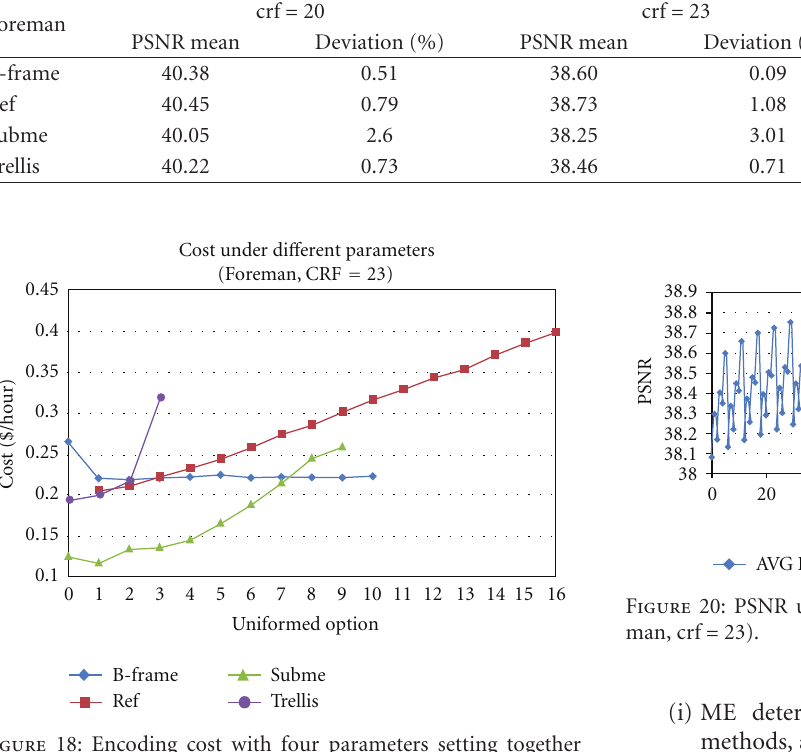
Figure 18: Encoding cost with four parameters setting together (Foreman, crf = 23).